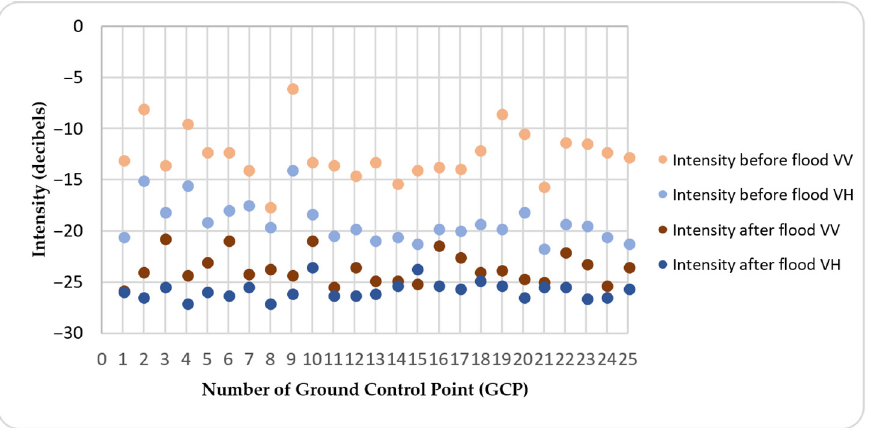
Figure 6. Graph of backscattered intensity before and after inundation process for VV and VH polarisation.